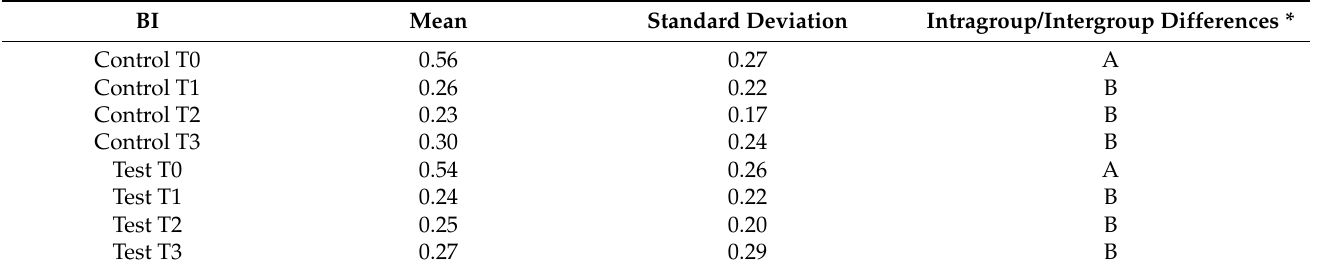
Table 2. Descriptive statistics of BI results.